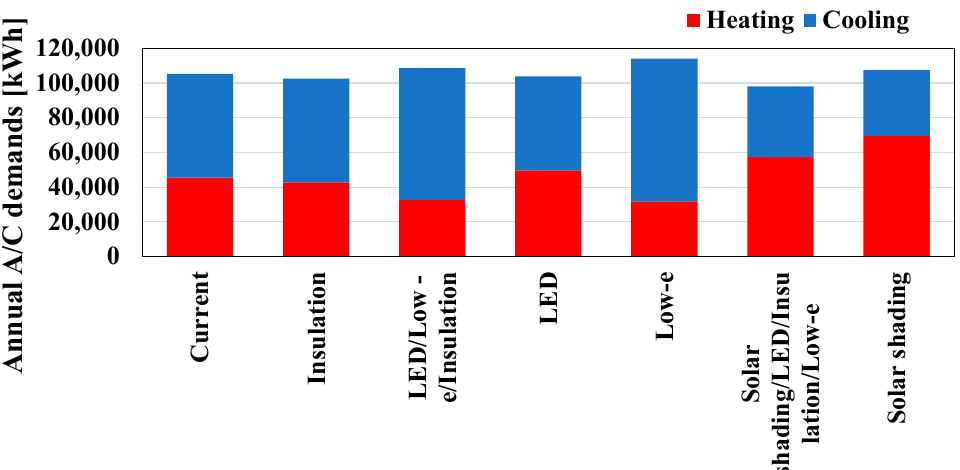
Figure 12. Total energy consumption for air-conditioning. The energy demands correspond to the current building and the building subjected to the different retrofit interventions.